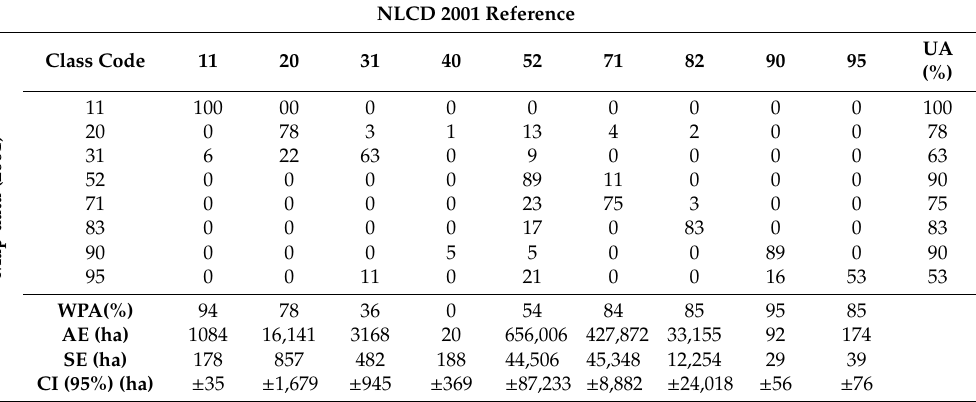
Table 6. Proportional error (confusion) matrix that represents the agreement and disagreement weighed by area for Lea County in